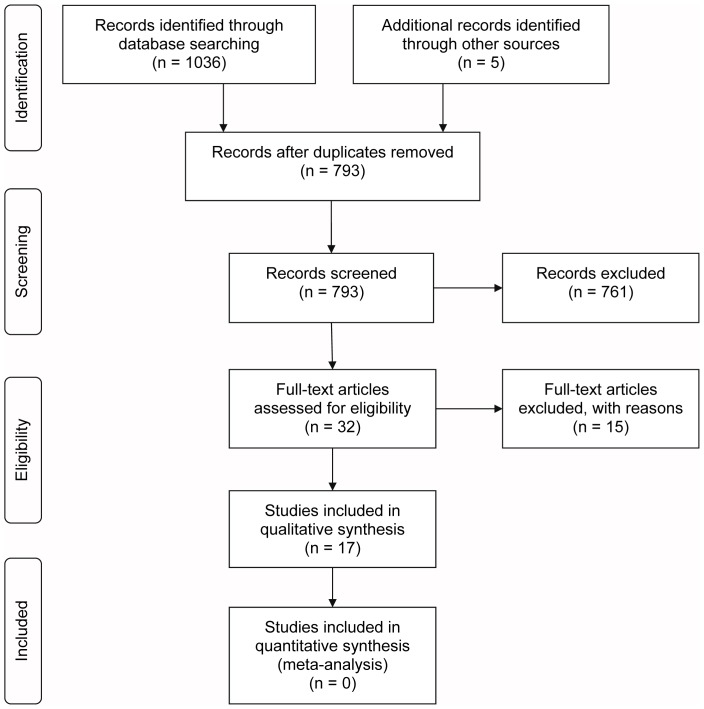
PRISMA flow diagram of study selection process.